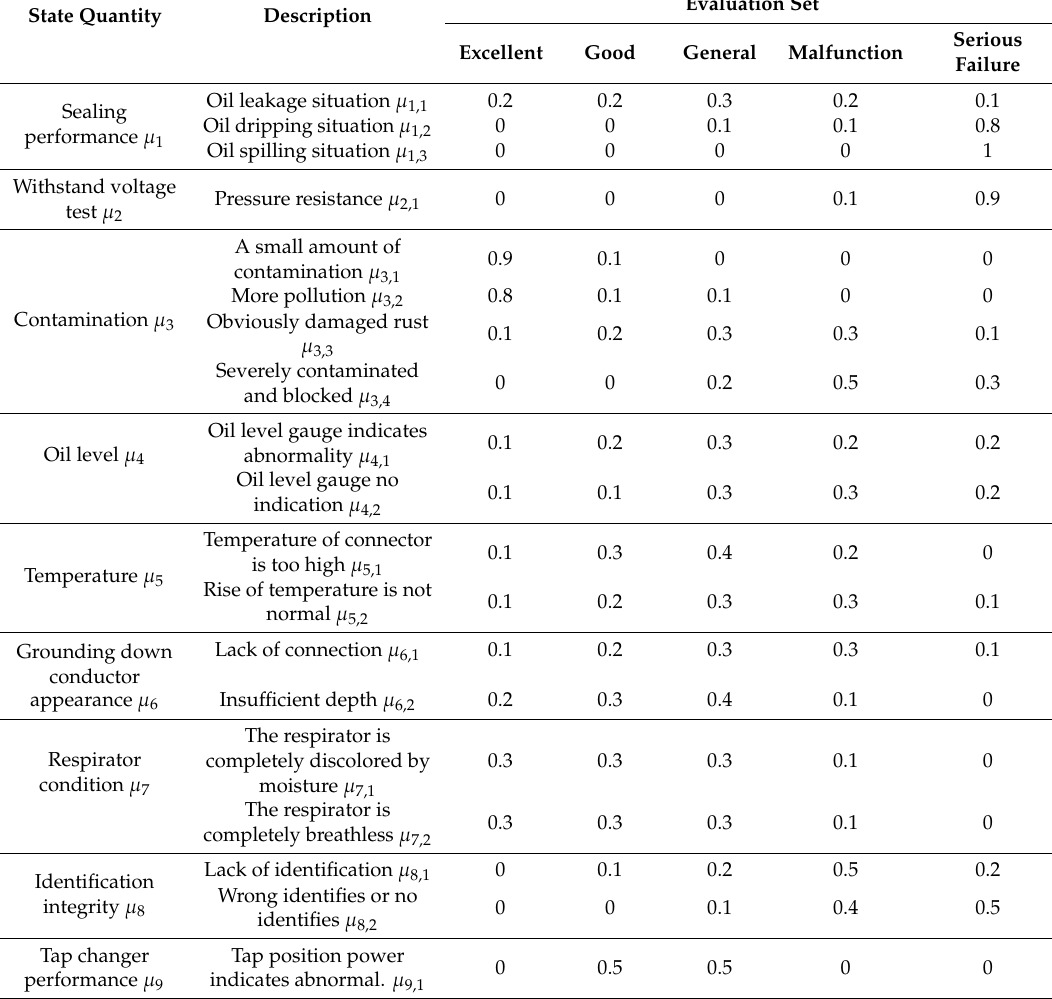
Table 4. Evaluation set of distribution transformer key state